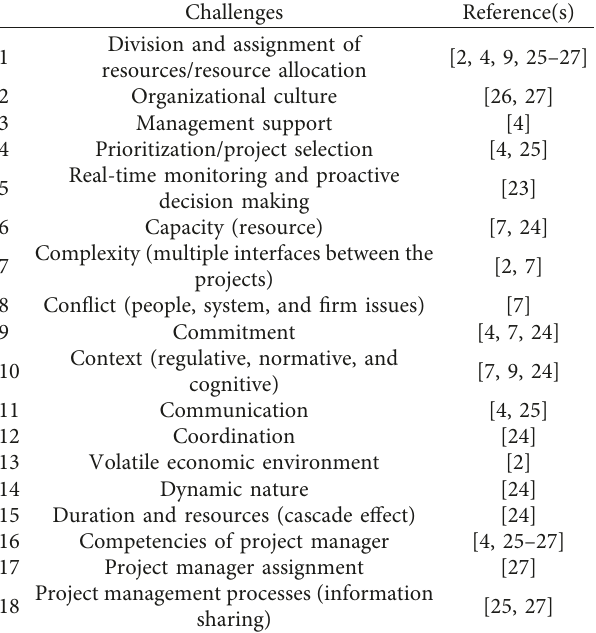
Table 1: Challenges in a multiproject environment